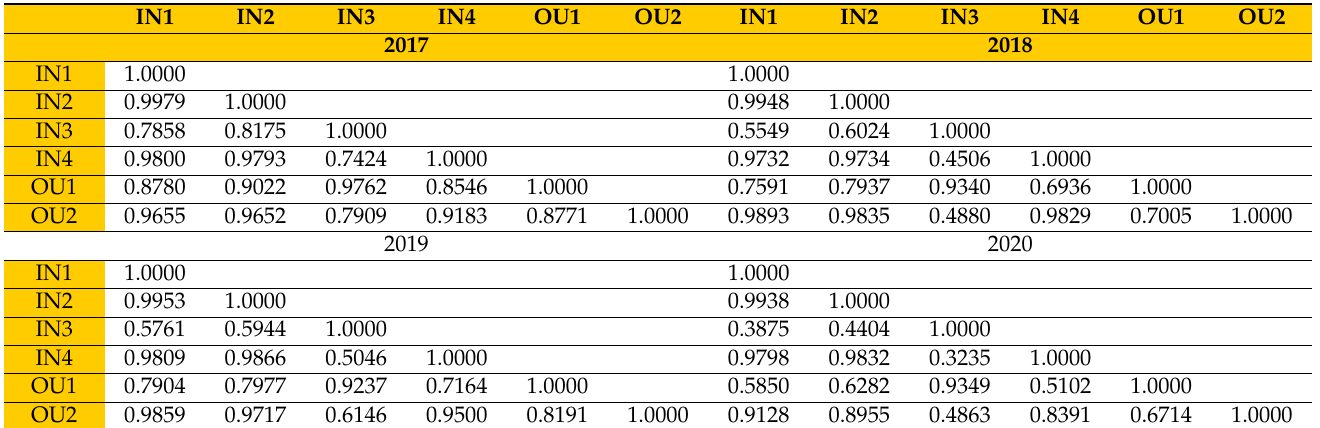
Table 6. Correlation coefficient (calculated by